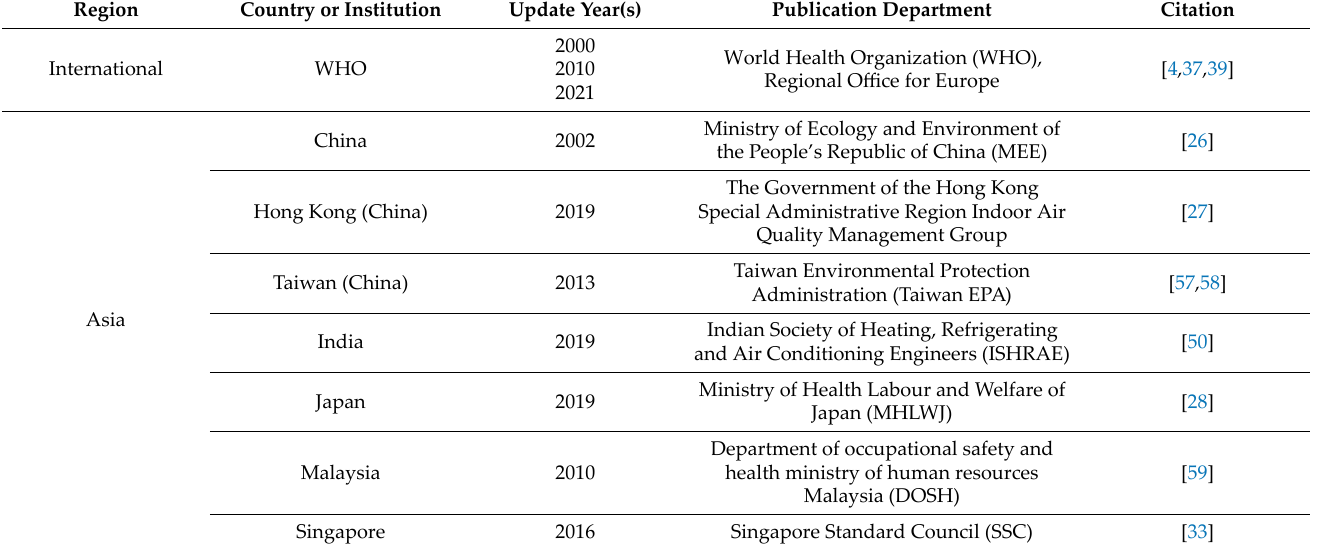
Table 1. Documents included in the